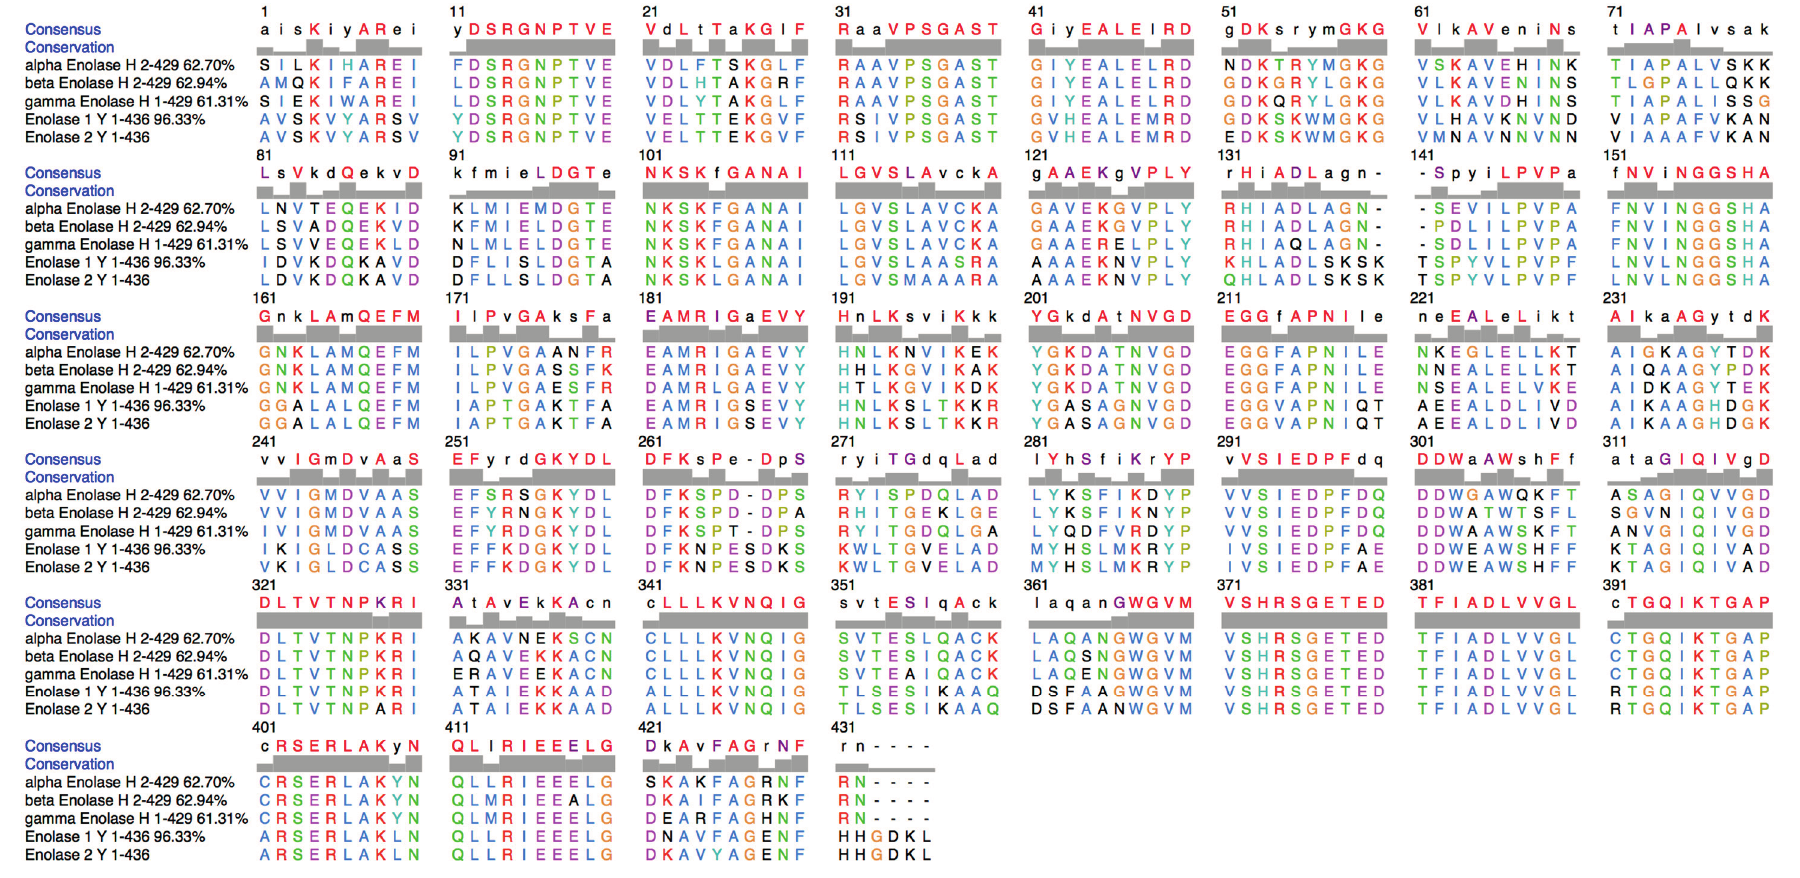
Figure 2. Sequence alignment of the three human enolases and of the two yeast enolases. Genebank Identification of sequences are as follows: α -Enolase 693933; β -Enolase 16878083; γ -Enolase 55669906; Enolase-1 628257676; Enolase 2